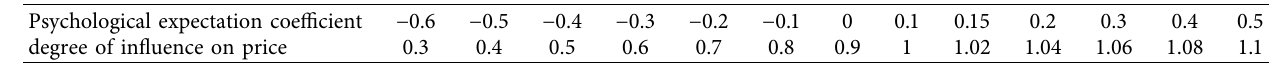
Table 2: Table function of psychological expectation influencing factors.